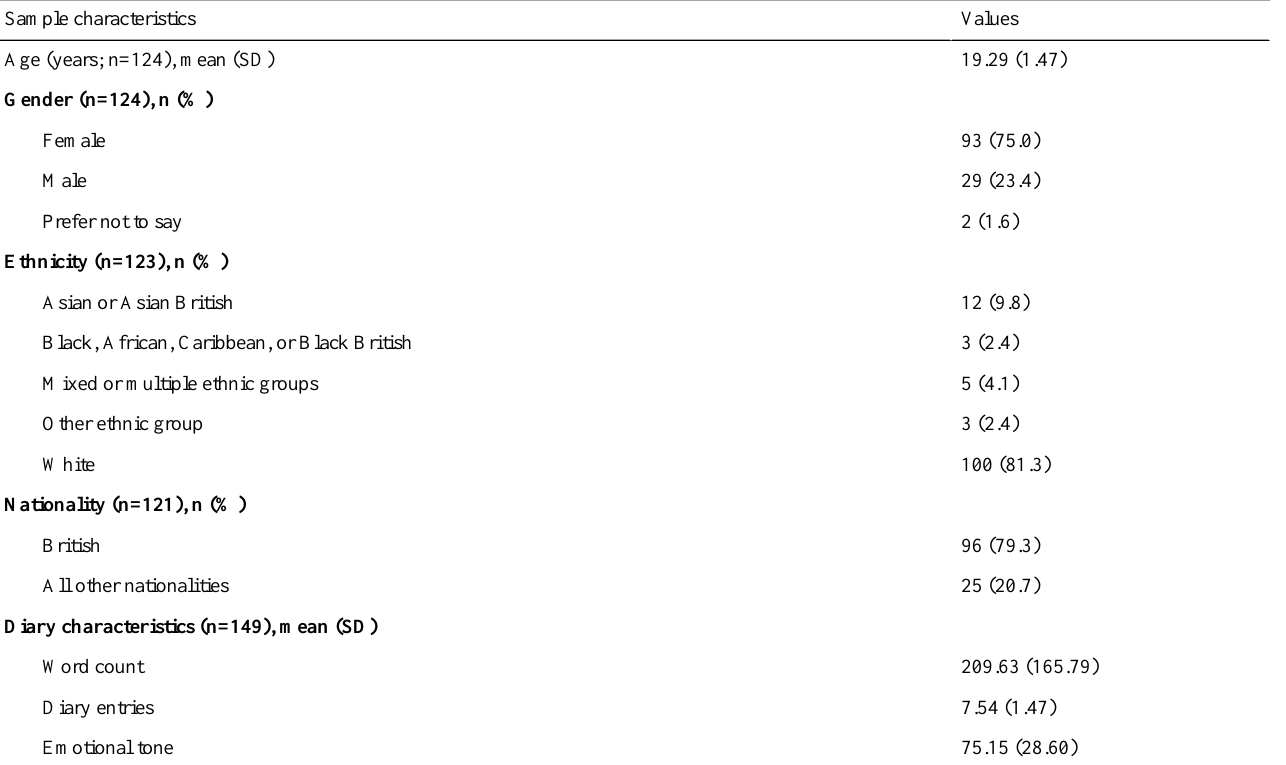
Table 2. Total sample sociodemographics. ValuesSample characteristics